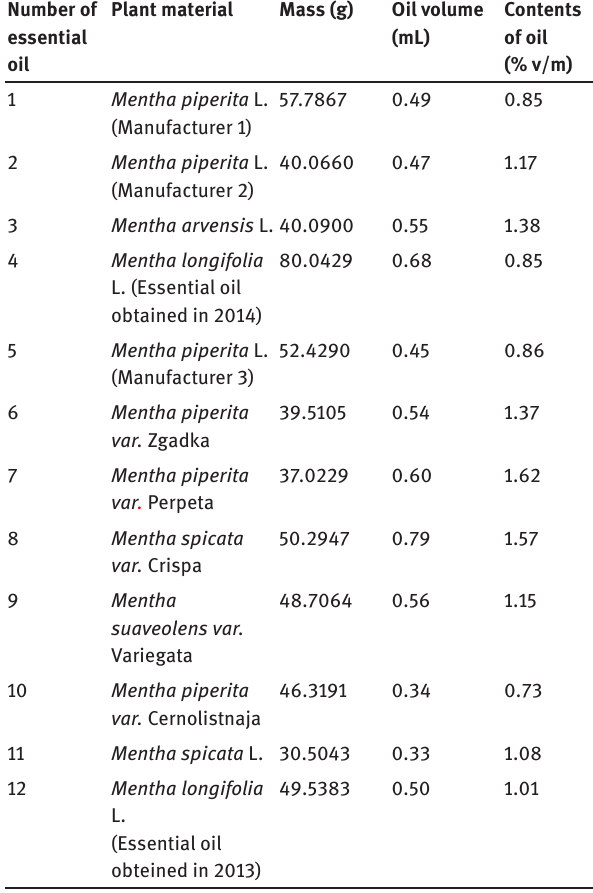
Table 1: Examined herbal substances and quantity of identified essentials